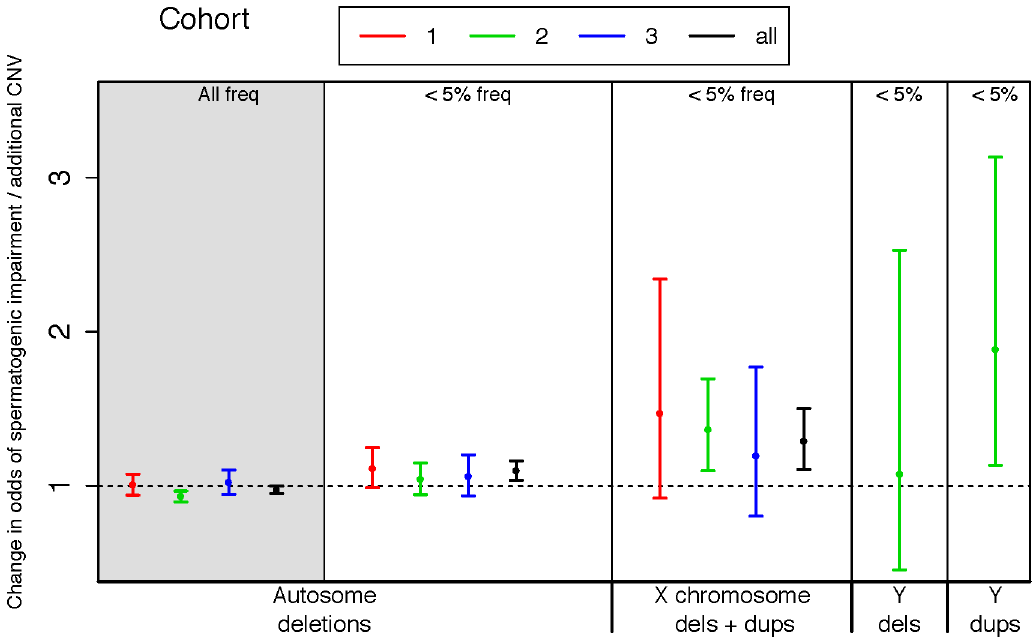
Figure 1. Rare variant burden in cases of spermatogenic impairment. We used logistic regression to estimate the influence of copy number variants (CNVs) on the odds of being diagnosed with impaired spermatogenesis in three case-control cohorts. The estimated odds of spermatogenic impairment is equal to, or slightly lower than, one when considering autosomal deletions of all frequencies (leftmost panel, shaded grey). However, when considering only autosomal deletions with call frequencies less than 5%, we observed a progressively increasing risk conferred by events on the autosomes, the X and the Y chromosomes. A very small number of Y-linked calls were made in cohorts 1 and 3 due to array design, thus we have only plotted Y-linked rates for cohort 2. Samples with Y-linked AZF deletions were excluded from the study. The odds ratio estimated from fitting a logistic regression model of total CNV count to disease status is plotted separately for each cohort, as well as the combined set of all cohorts (black points). Cohort 1=Utah (Illumina 370K), 2=Porto and Weill Cornell (Affymetrix 6.0), 3=WUSTL (Illumina OmniExpress), All=meta-analysis of all three cohorts. Sample sizes used in CNV analysis are n=83 cases and 62 controls for cohort 1, n=183 cases and 974 controls for cohort 2, and n=61 cases and 100 controls for cohort